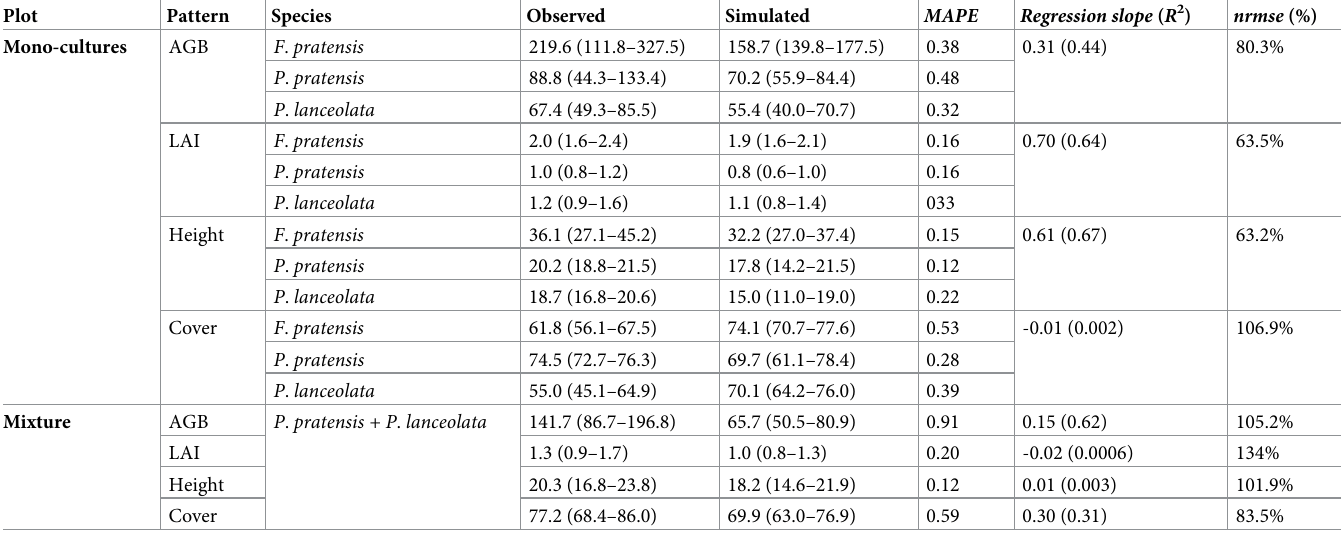
Table 3. Comparison of observed and simulated vegetation patterns and its